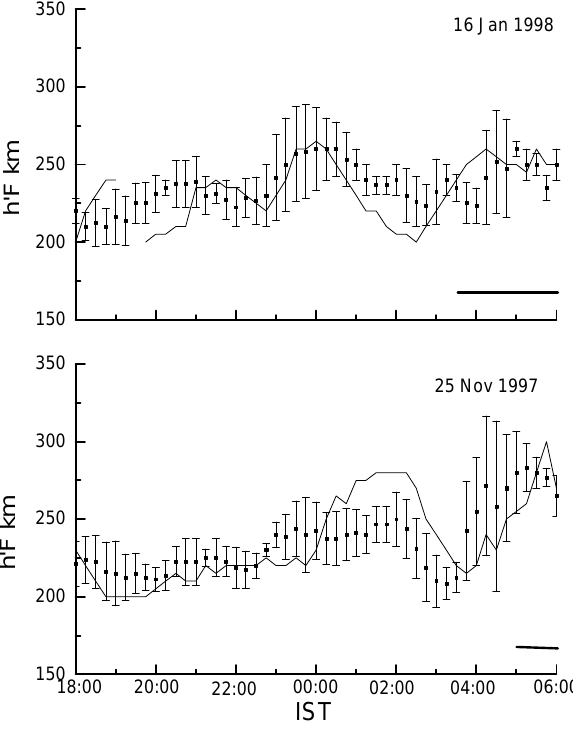
Fig. 3. Same as in Fig. 2 for two typical post midnight spread-F days in winter